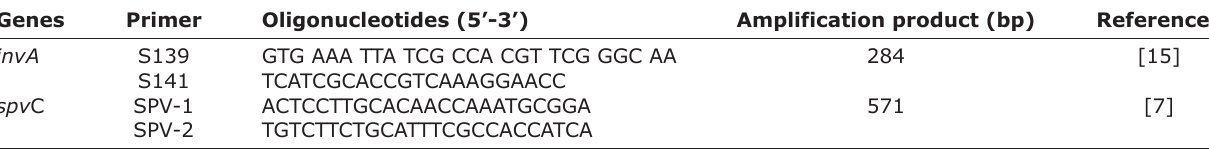
Table-1: Oligonucleotides (primers) used for detection of virulence genes ( invA and s pvC ) of Salmonella Gallinarum. Genes Primer